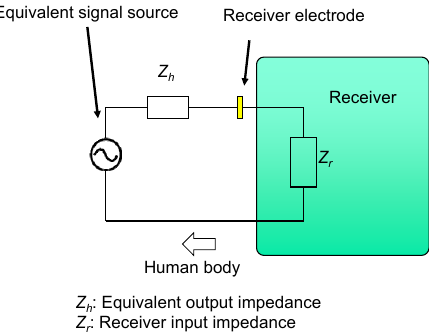
Figure 1. Equivalent circuit of HBC transmission.